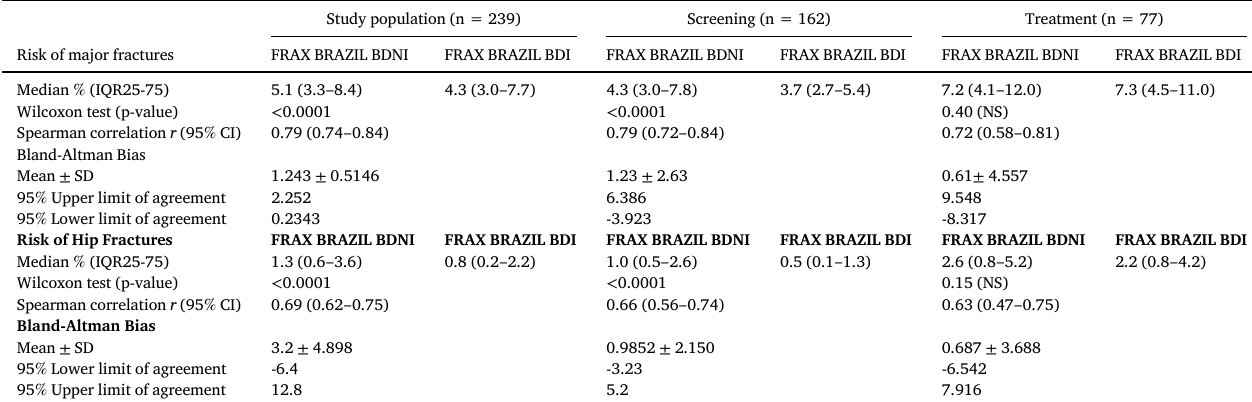
Table 2 Summary of risk assessment tools with and without bone-density information for patients undergoing DEXA for screening or treatment control indications.